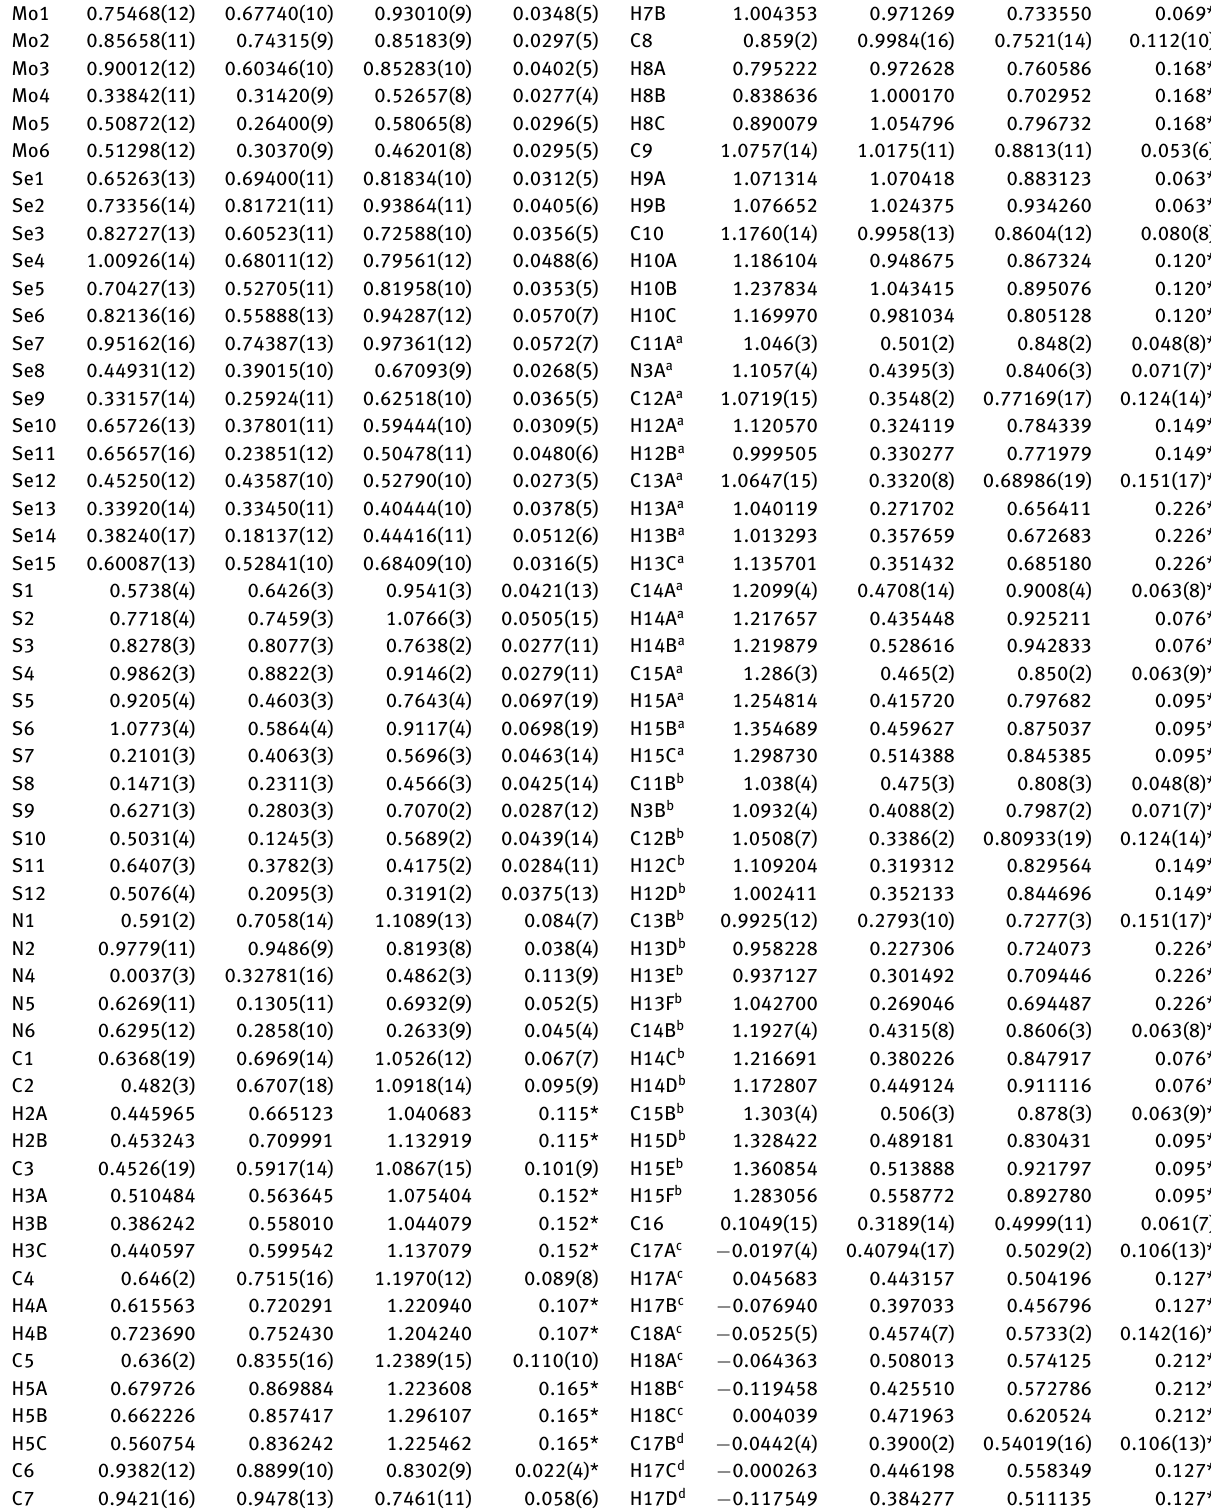
Table 2: Fractional atomic coordinates and isotropic or equivalent isotropic displacement parameters (Å 2